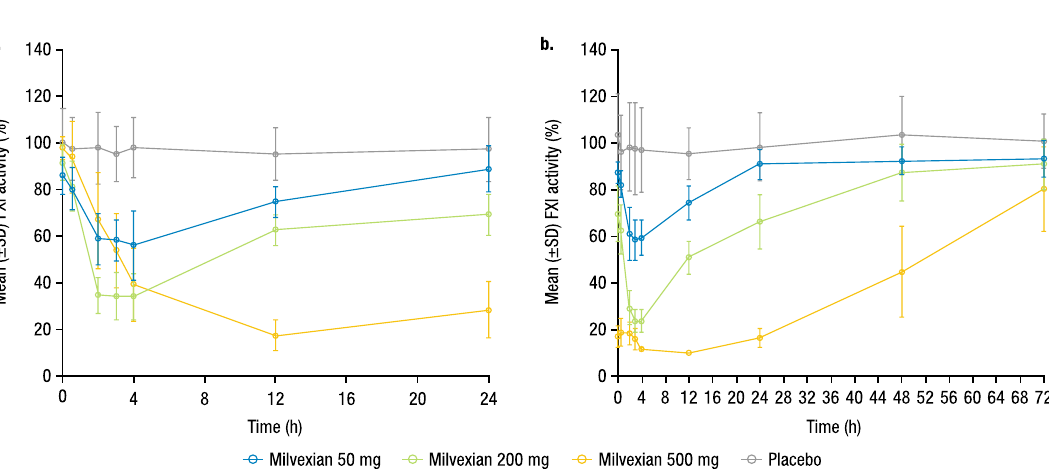
Figure 4. Mean (± SD) FXI clotting activity over time on ( a ) Day 1 and ( b ) Day 14. SD, standard deviation; FXI, factor XI. Milvexian 50 mg and 200 mg were administered under fasted conditions. Milvexian 500 mg was administered under fed